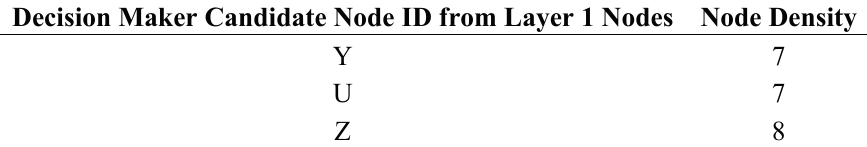
Table 2. Forwarding Node Table at node